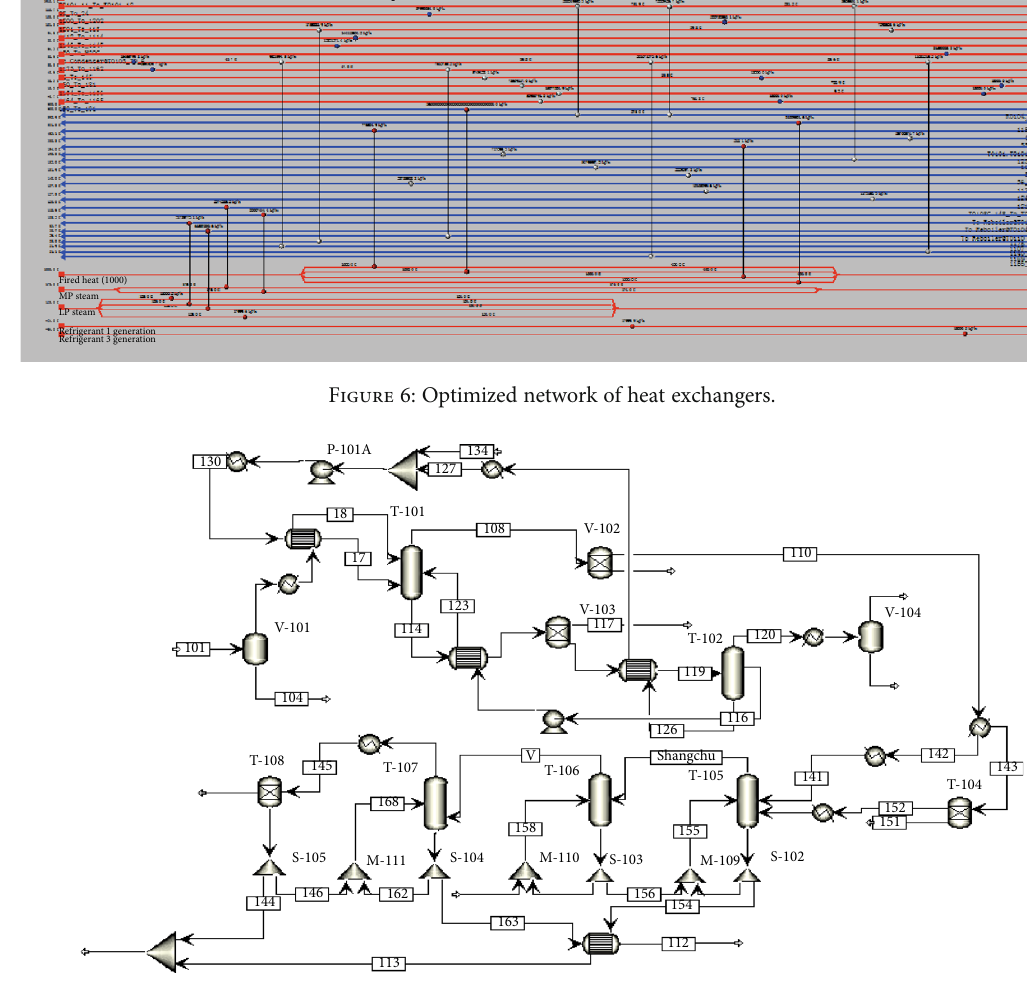
Figure 7: Optimized